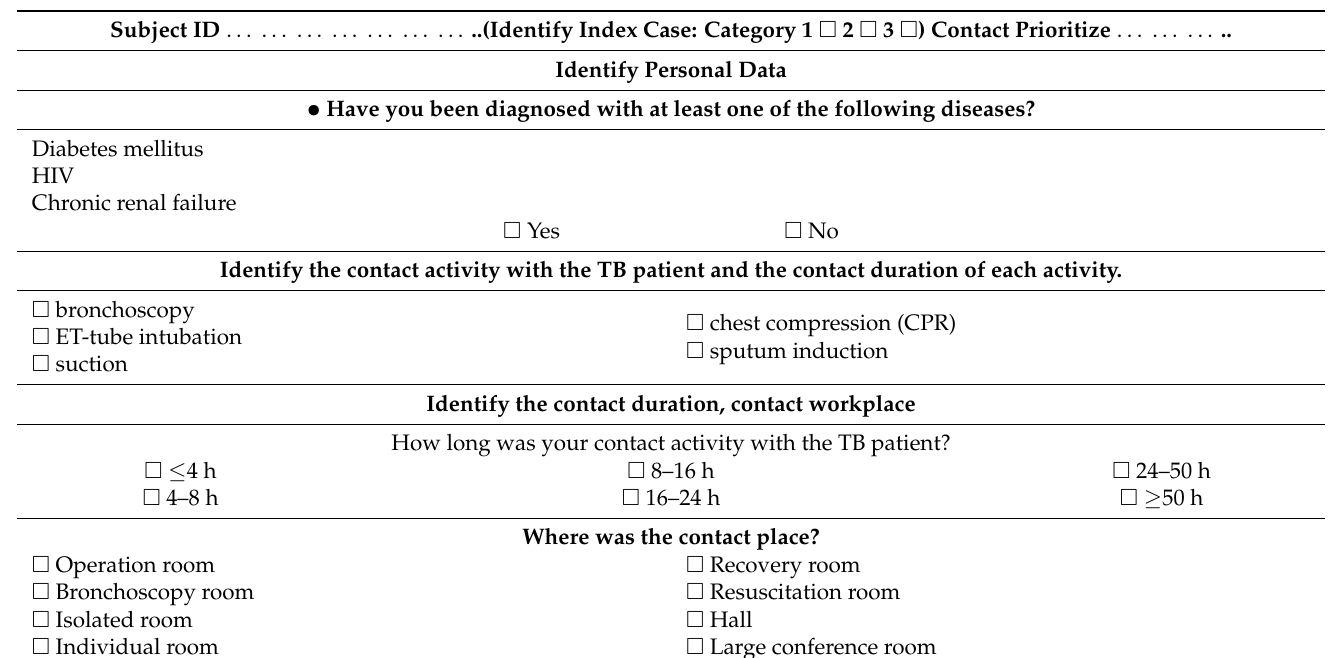
Table A2. Present Self-Assessment (PSA)